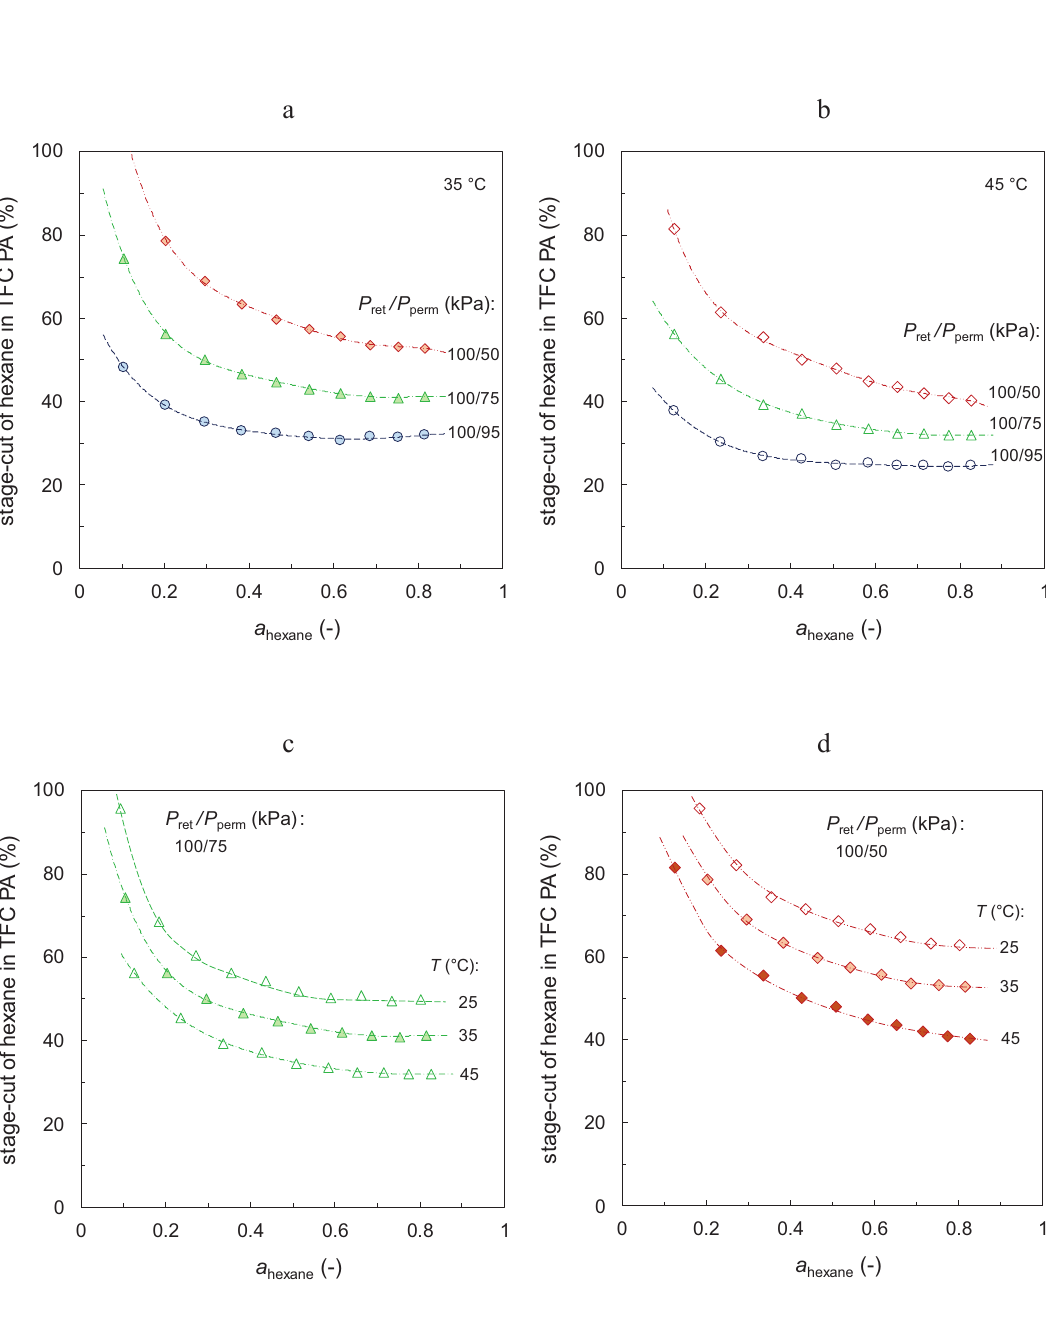
Fig. S6 – Hexane stage-cut in TFC PA (Toray) membrane: activity dependence at three different trans-membrane pressures at a) 35 °C and b) 45 °C, activity dependence at three temperatures at trans-membrane pressure c) 25 kPa and d) 50 kPa; The lines are intended as a guide to the eye.